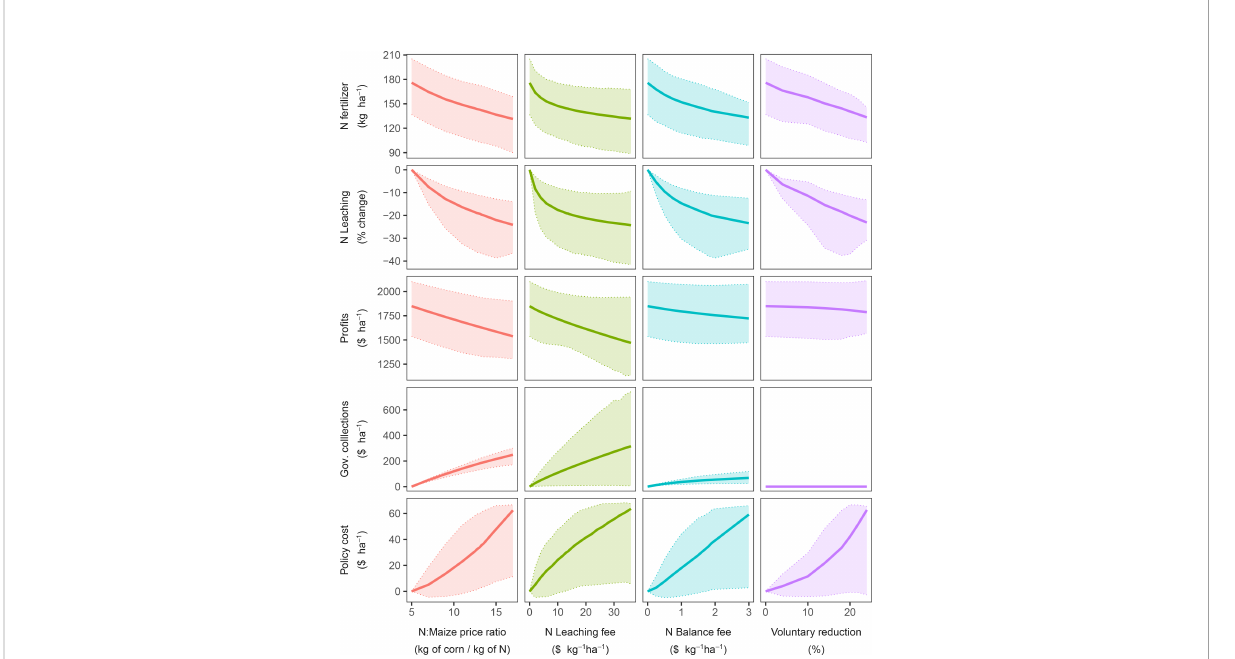
FIGURE 2 Trajectory of N fertilizer use, N leaching, Farm pro fi ts, government collections, and policy cost for the four policies. Solid line shows the mean. The shaded area indicates the 10 and 90% quantiles across fi elds (averaged across